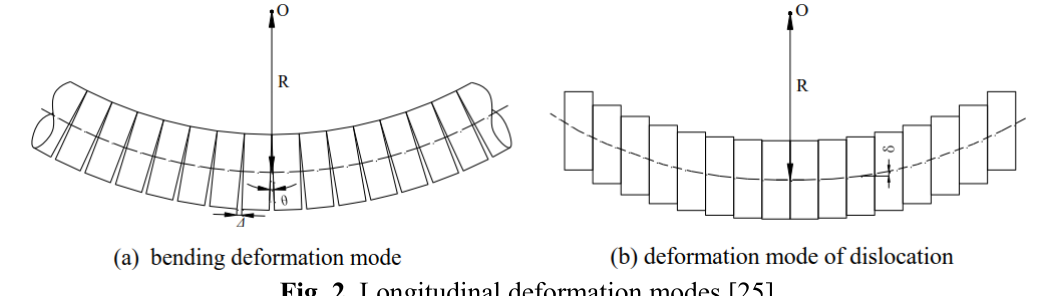
Fig. 2. Longitudinal deformation modes